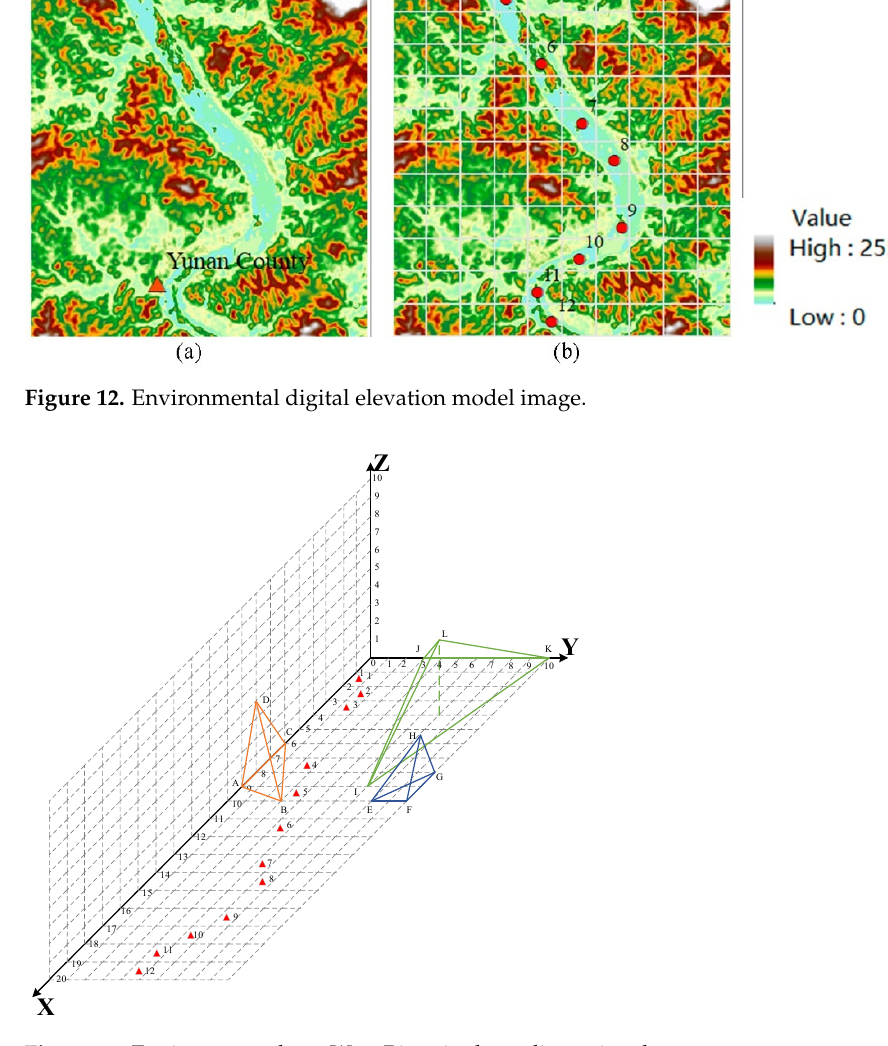
Figure 13. Environment about West River in three-dimensional space.